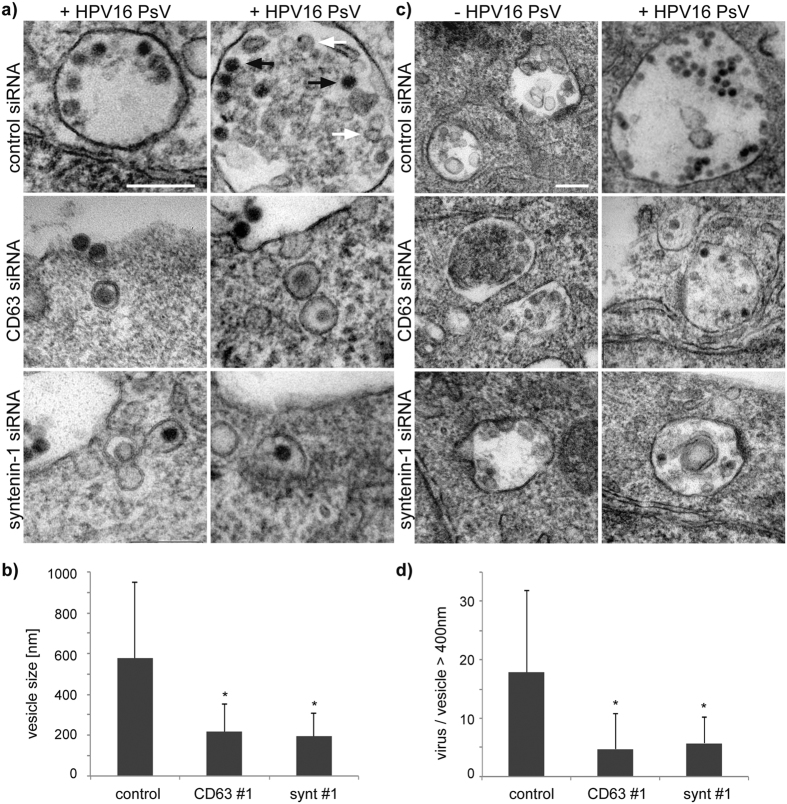
Ultrastructural analyses of HPV16-filled endosomes.(a–d) HeLa cells were treated with CD63 or control siRNA and infected with HPV16 PsV. (a) Representative electron micrographs illustrating the morphology of virus containing endosomes (black arrow: HPV16 PsV; white arrow: intraluminal vesicles). Scale bar represents 200 nm. (b) For quantification of the size (diameter) of virus containing endosomes, 20 micrographs of target and control siRNA-treated cells were measured. (c) Representative electron micrographs of virus containing endosomes (diameter > 400 nm) after mock or HPV16 PsV infection. Scale bar represents 200 nm. (d) Quantification of viruses per vesicle with diameter >400 nm was determined by analysing 20 micrographs of control or target siRNA-treated cells, respectively. *P < 0.05 compared to control.